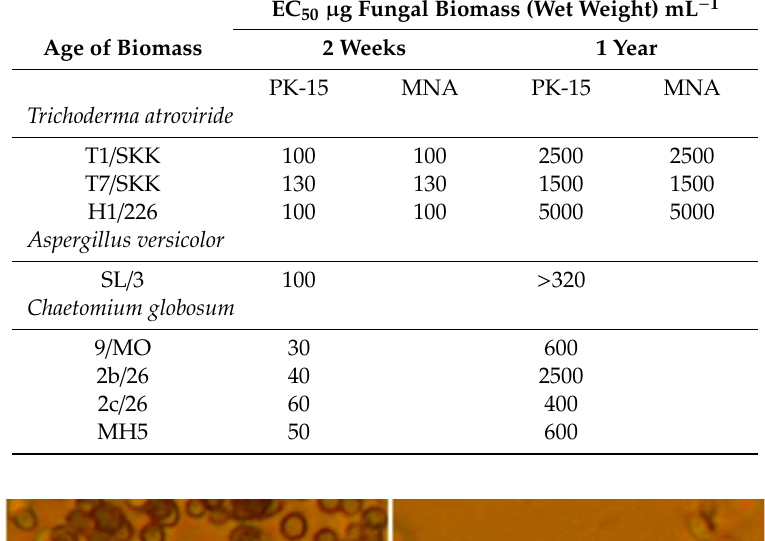
Table 2. Toxic responses in in vitro assays with somatic mammalian cell lines PK-15 and MNA of actively growing, fresh biomass and dry, old fungal biomass grown on malt extract agar.